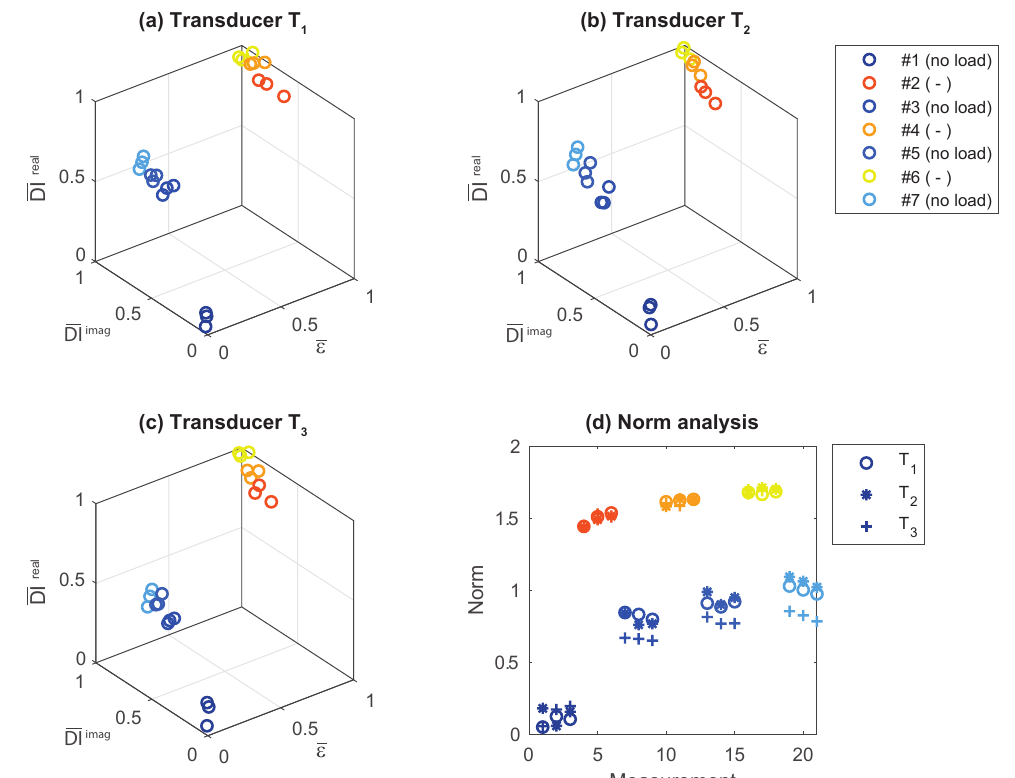
Figure 9. ( a – c ) Cluster analysis for transducers T 1 – T 3 where all quantities have been normalized to the interval [0, 1]. ( d ) Norm relative to the coordinate origin (0,0,0). All piezoelectric transducers contain similar information about damage. This is plausible, because pin failures occurred around the circumference of the specimen. The proposed cluster analysis enables a clear distinction between the different loading and damage